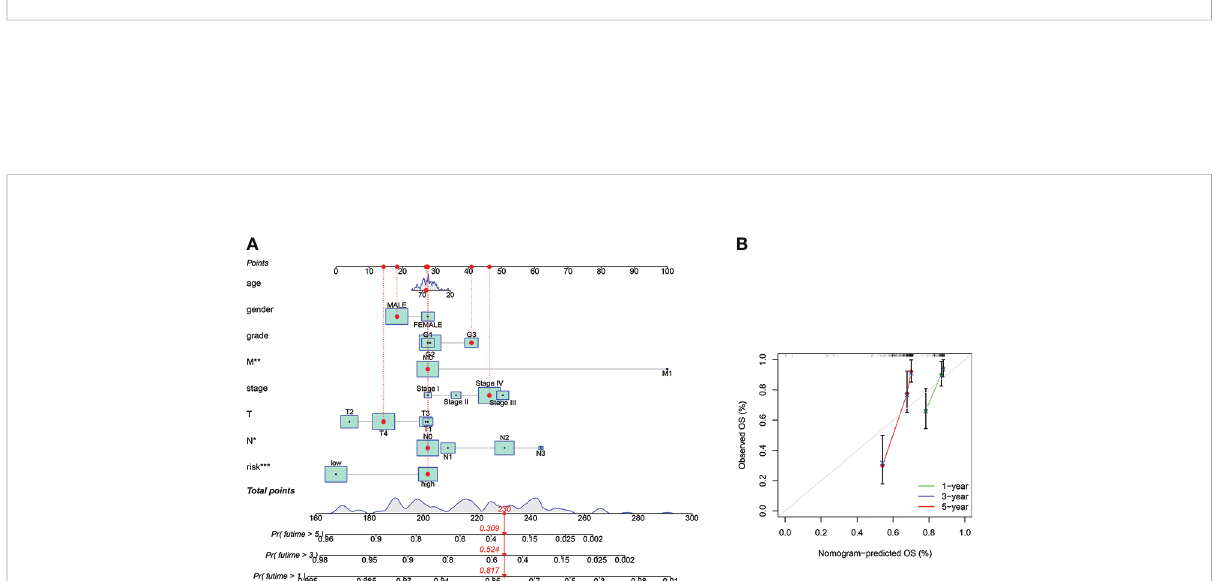
FIGURE 6 The prognostic nomogram construction and evaluation. (A) The nomogram was established for HNSCC patients ’ OS prediction at 1, 2, and 3 years, a personalized OS prediction model was made according to gender, age, grade, risk score, TMN, and stage. The nomogram was made for the 1-, 3-, and 5-year OS prediction by the risk levels and variables. (B) The nomogram calibration plot for OS prediction at 1, 2, and 3 years, The nomogram prediction accuracy was con fi rmed by calibration plots highly congruent with the actual 1- and 3-year OS values. *means p < 0.05, **means p < 0.01, ***means p <